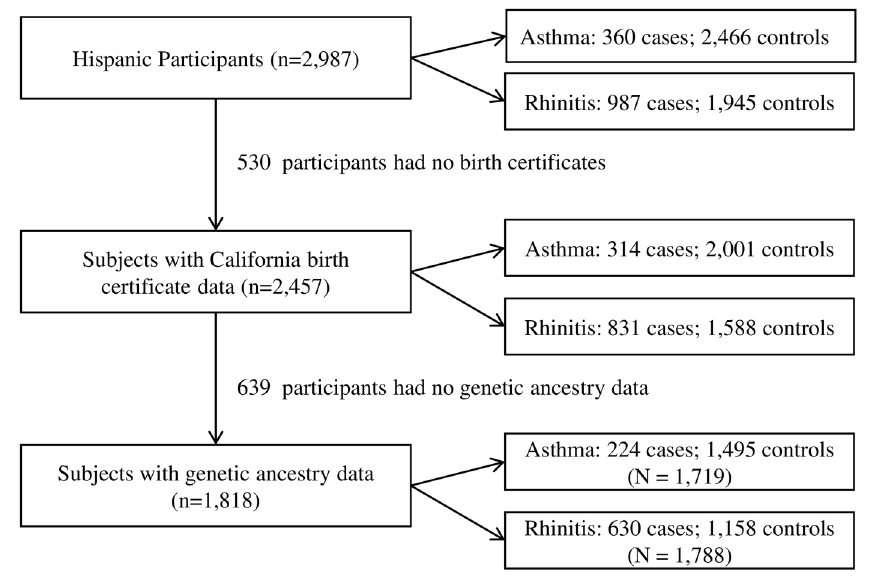
Fig 1. Flow Chart of Study Population and Sample Size. The figure shows the number of Hispanic children available in the Children ’ s Health Study in 2003, subjects excluded for not having birth certificate or genetic ancestry data, and final sample size available for analyzing the associations of genetic ancestry on asthma (N = 1,719) and rhinitis (N = 1,788). 25cM from a validated list of 3,011 AIMs, with 100 AIMs each to optimally distinguish between